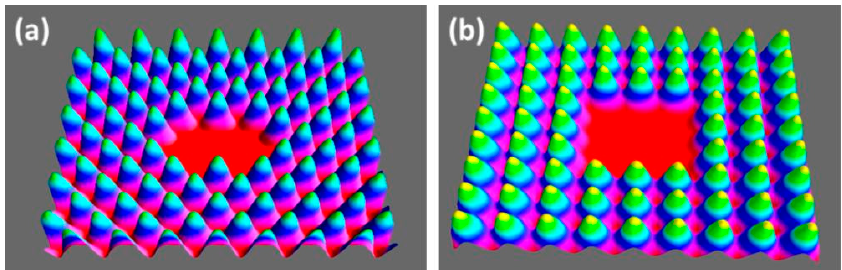
Figure 11. Hexagonal ( a ) and orthogonal ( b ) arrays of elliptical axicons programmed into the SLM phase map for the generation of nondiffracting needle beams (parts of larger arrays, optimized for 45° illumination, and 790 nm diode laser). In the central regions, a few elements (7 and 9, respectively) were eliminated to enable for centering the system, identifying the order of self-imaging and visualizing residual diffraction effects (FOV on the SLM: 3.3 × 3.3 mm 2 ).